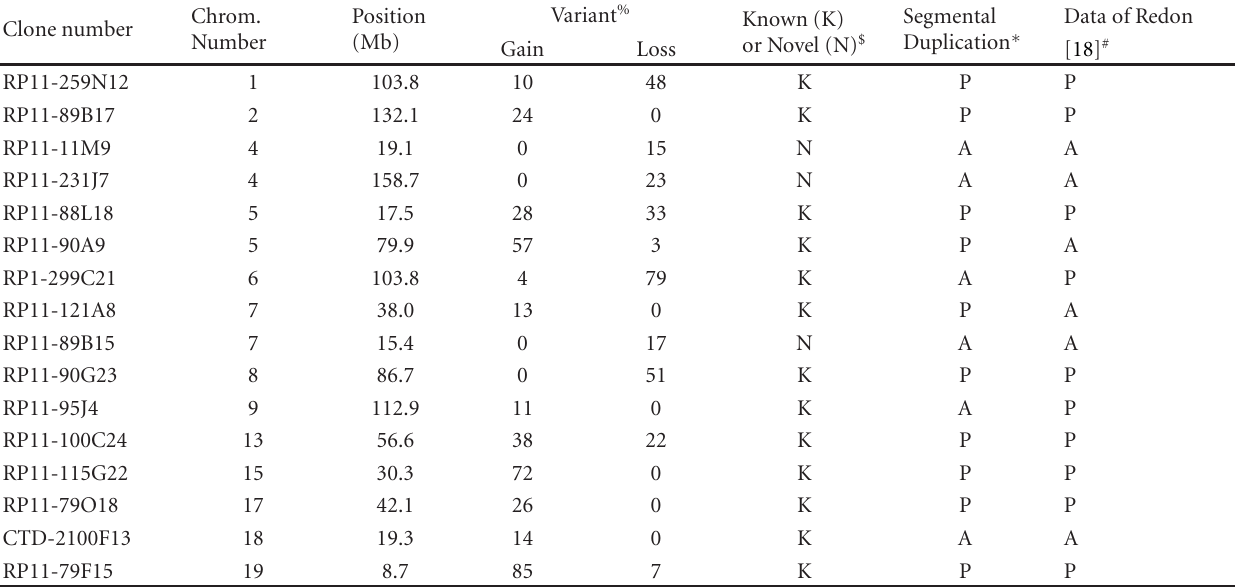
Table 1: Summary of highly polymorphic CNVs detected.